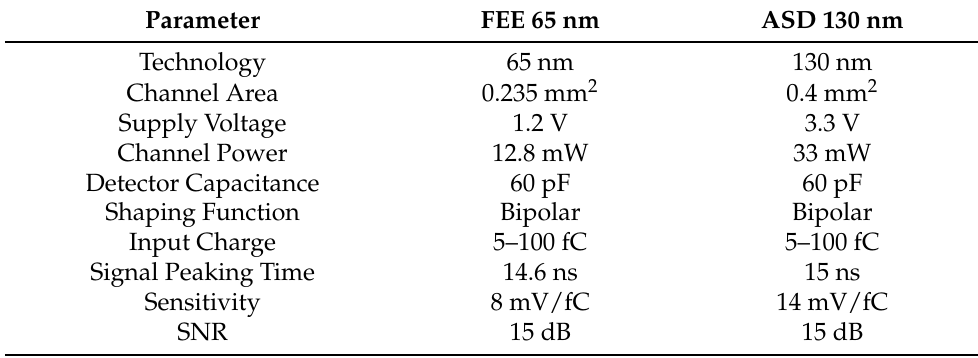
Table 2. State-of-the-art